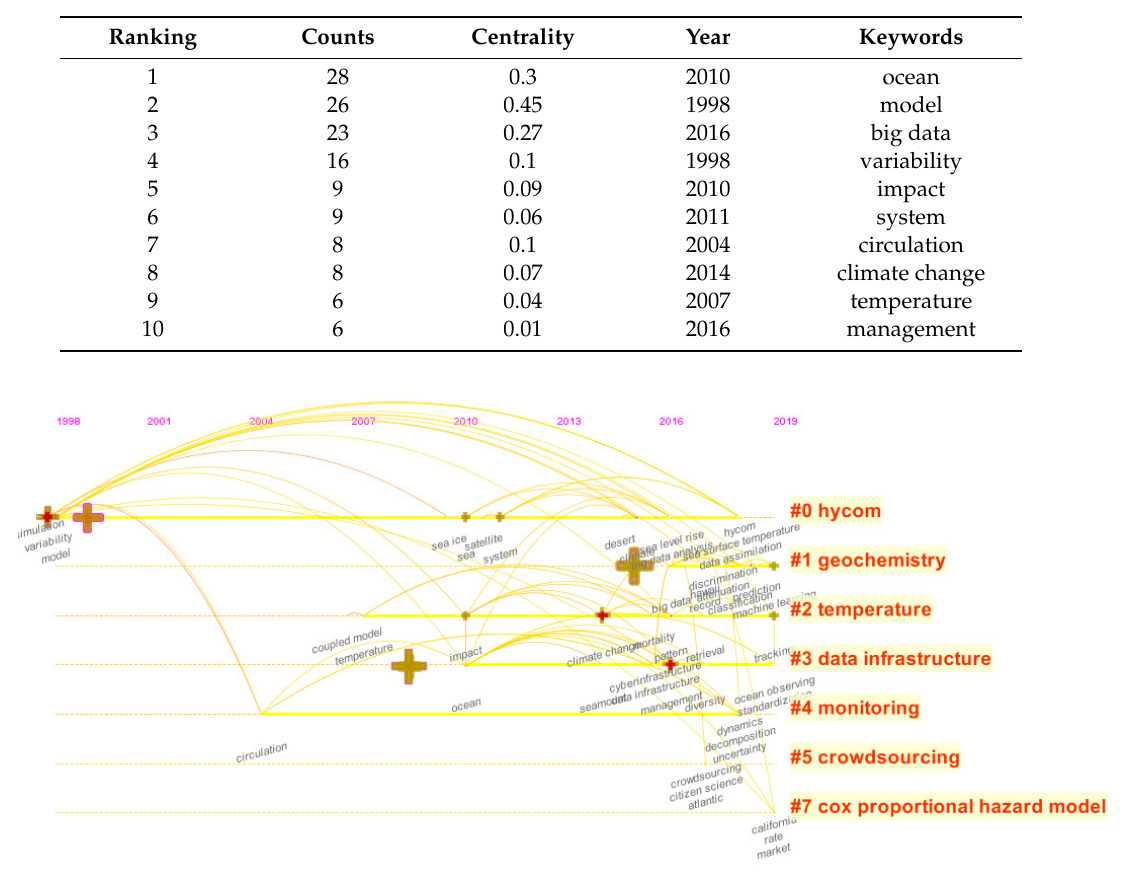
Table 7. Top 10—keyword co-occurrence of big ocean data documents. Figure 9. Keywords co-occurrence network map.